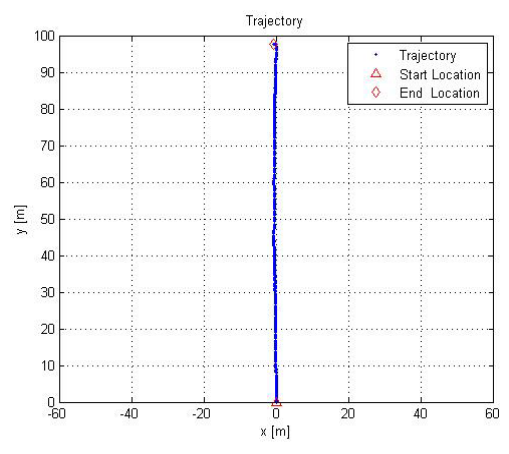
Figure 10. Hopping path of 50 meters